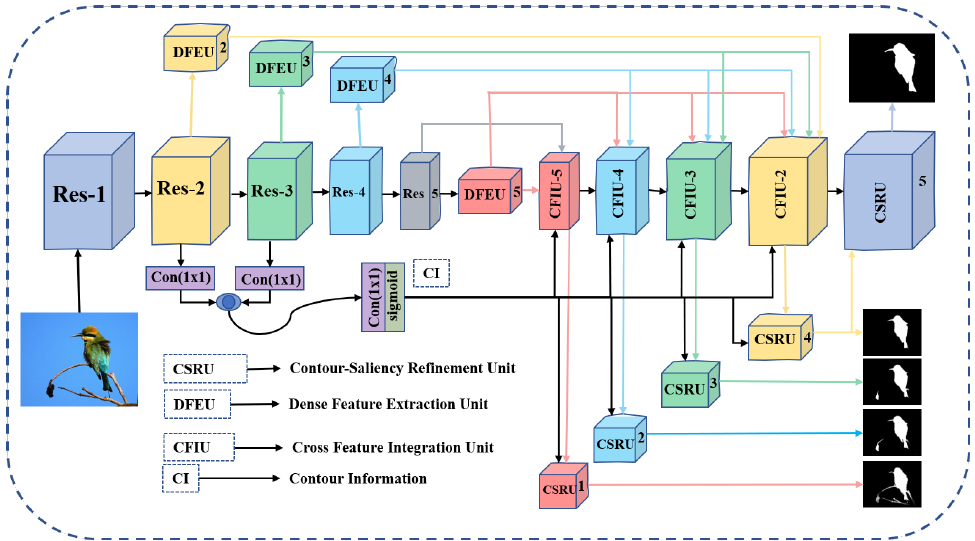
Figure 2. Overview of the proposed AWANet: attentive-aware wide-kernels asymmetrical network with blended contour information for salient object